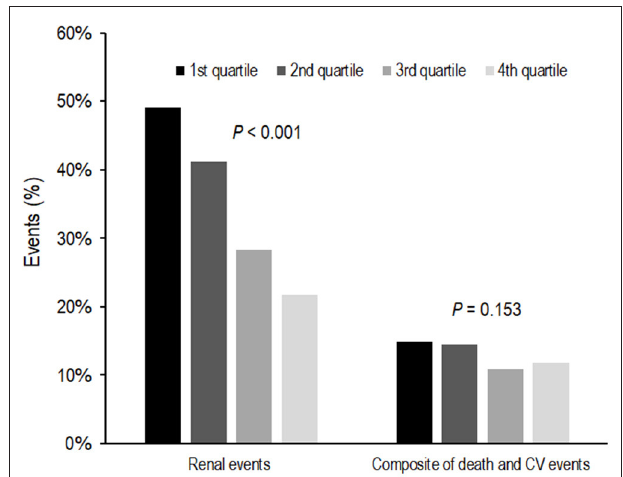
FIGURE 1 | Event rates for renal events and composites of death and CV events according to Klotho/FGF23 ratio. The first quartile of the Klotho/FGF23 ratio group was at a greater risk of developing renal events compared to the other quartile groups ( P < 0.001). Composites of death and CV events were not significantly different according to Klotho/FGF23 ratio groups ( P = 0.153). FGF23, fibroblast growth factor 23; CV, cardiovascular.